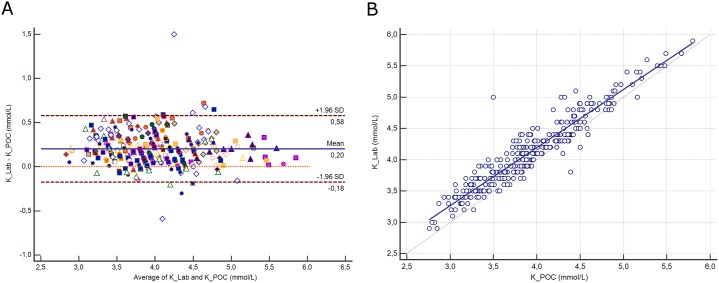
2A. Bland-Altman plot showing the difference versus the average of potassium (K) measured by the central Lab analyzer and by the POC Siemens RAPIDPoint 500 blood gas system. Bias, upper and lower limits of agreement (±1.96 SD) are represented. The red dotted line indicates equality (difference = 0). There is one marker for each patient. 2B. Scatter diagram showing Deming regression analysis for sodium potassium (K) measured by the central Lab analyzer and by the POC Siemens RAPIDPoint 500 blood gas system. The regression line (solid line) and the identity line (x = y, dotted line) are represented.